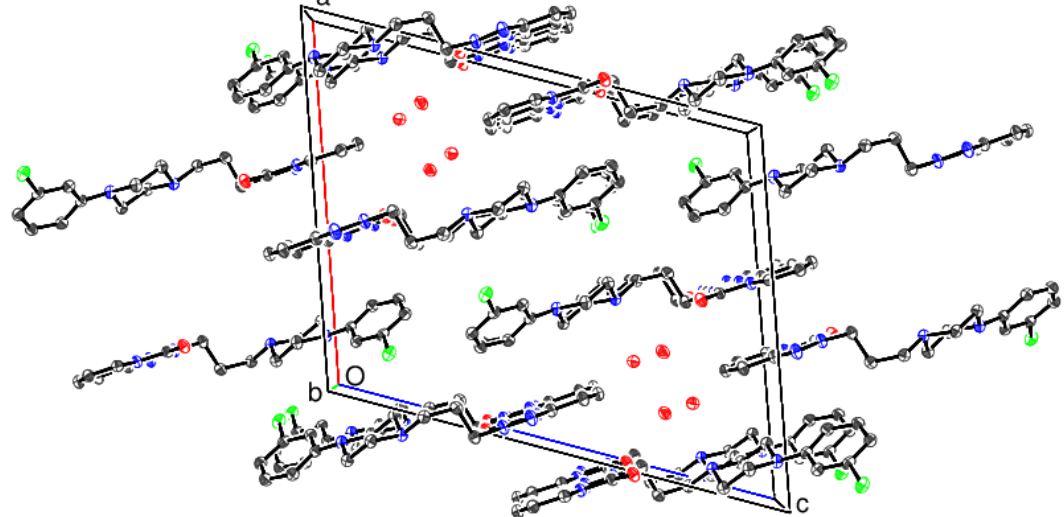
Figure 7. The unit cell packing for β trazodone dihydrate viewed down [010] with H atoms omitted for clarity.